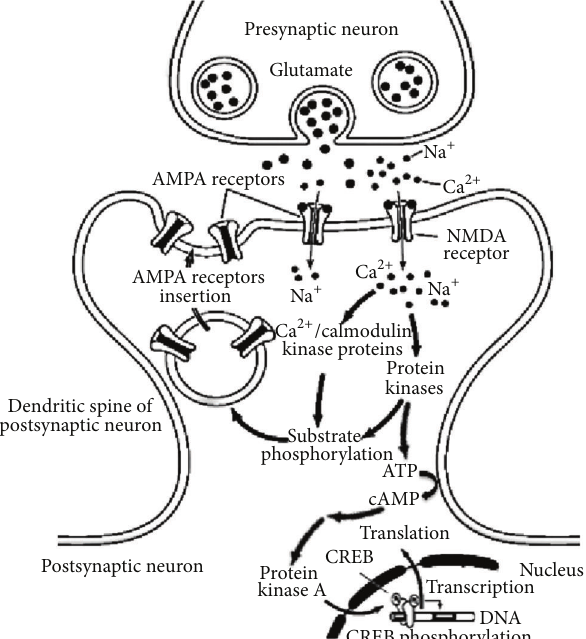
Figure 1: Molecular mechanisms underlying long-lasting modifica- tions of synaptic transmission. After presynaptic glutamate release, the NMDA channel opens only when the postsynaptic neuron is sufficiently depolarized. As a result, the permeability of Ca 2+ increases and Ca 2+ ions activate postsynaptic protein kinases. These kinases may then act to insert new AMPA receptors into the postsynaptic spine, thereby increasing the sensitivity to glutamate. The activation of second-messenger pathways (e.g., ↑ cAMP) that subsequently set in motion the catalytic subunit of the protein kinase A results in the phosphorylation of the transcriptional regulator CREB. This turns on the expression of a number of genes (those containing the CRE promoter area) that produce long-lasting structural and functional changes on the